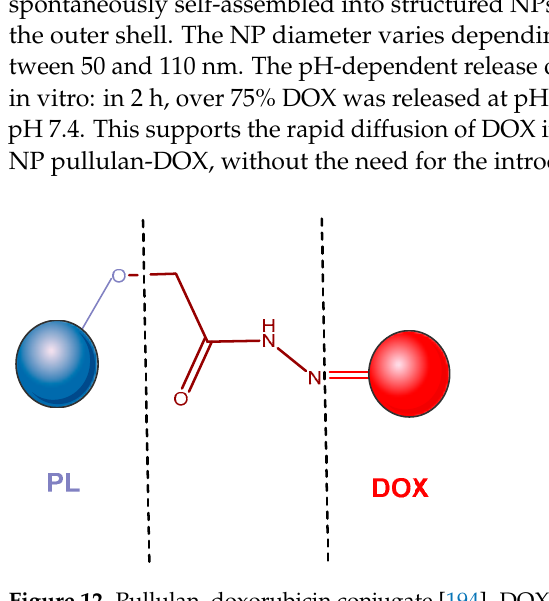
Figure 12. Pullulan–doxorubicin conjugate [194]. DOX—doxorubicin; PL—pullulan.